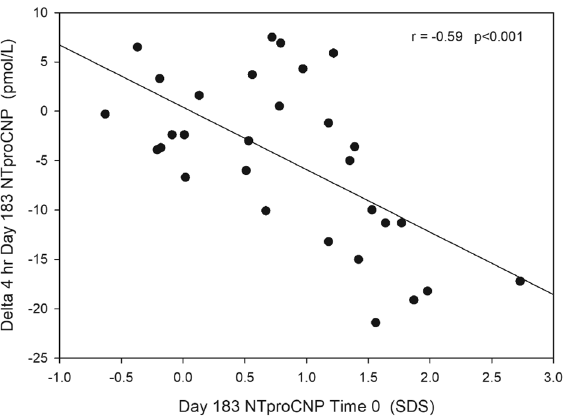
Figure 3. Relationship between change (delta) in plasma NTproCNP concentration at 4 h after injection on Day 183 and NTproCNP SDS prior to injection on the same